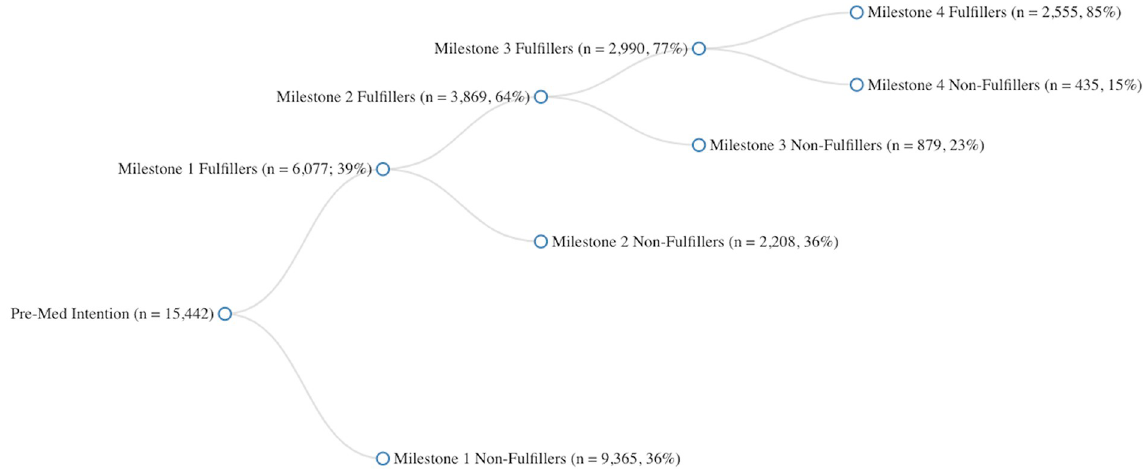
Fig 1. Pattern of continuing fulfillment of pre-med coursework at various milestones. Pre-Med Intention = students who indicated intentions of majoring in pre-medicine at the time of taking SAT, Milestone 1 = whether students took a first semester of general chemistry, biology, and physics, Milestone 2 = whether students who completed Milestone1 took a second semester of general chemistry, biology, and physics, Milestone 3 = whether students who completed Milestone2 took a first semester of organic chemistry, Milestone 4 (full fulfillment) = whether students who completed Milestone3 took a second semester of organic chemistry or a semester of